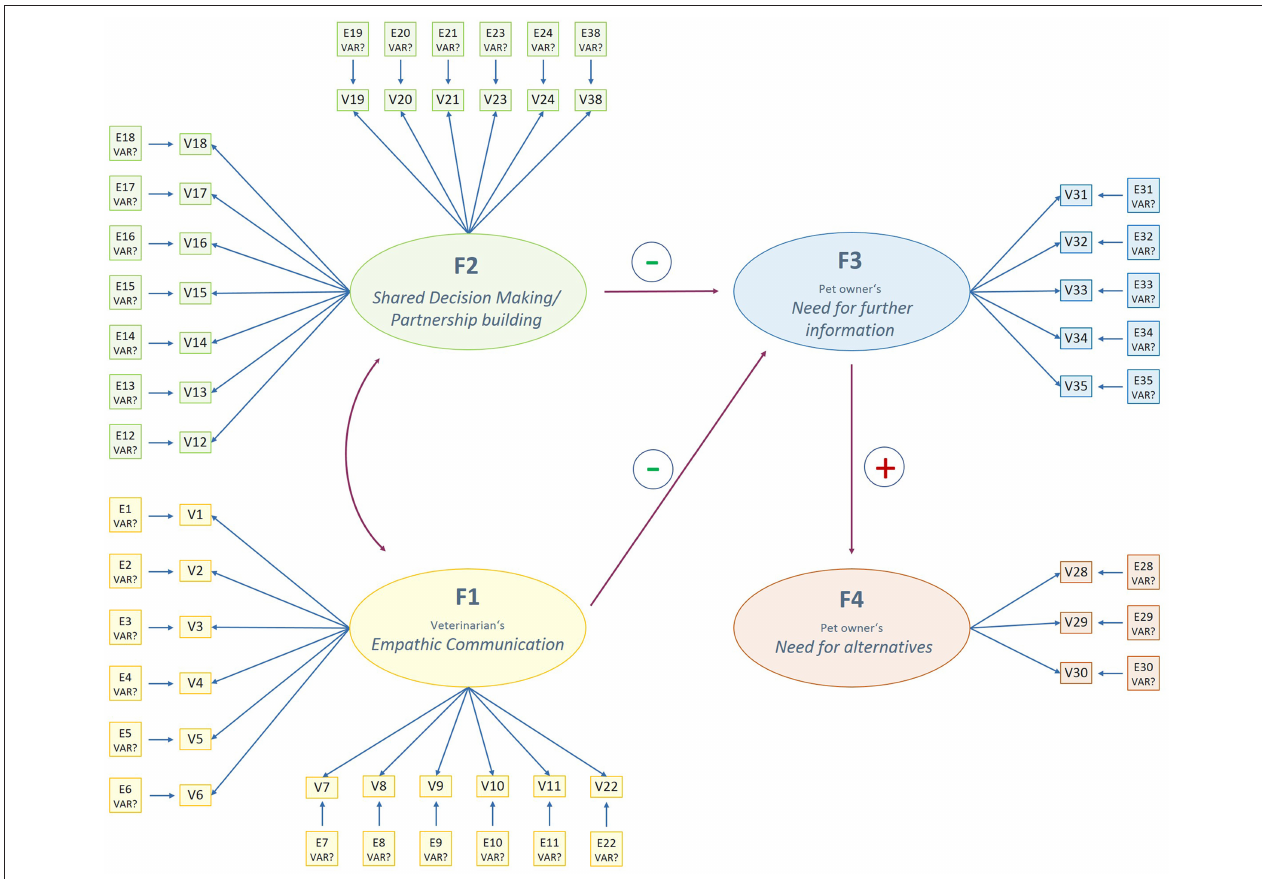
FIGURE 1 | Preliminary structural equation model describing latent factors of pet owners’ perception of communication with their veterinarian. Directional single-headed arrows describe hypothesized directional influences. The curved double-headed arrow hypothesizes a bilateral correlation between factors. F, latent factor. V, measurement item. E, Error